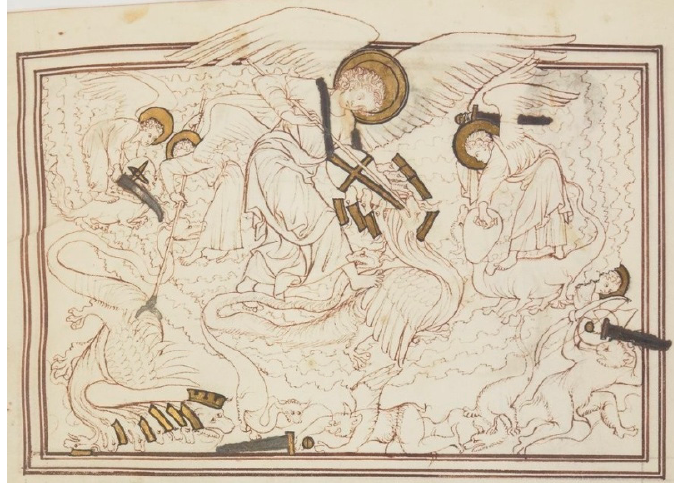
Figure 12. BNF 10474 (Paris Biblioth é que Nationale MS lat. 10474), Fol. 22 r , c. 1270–90, © Biblioth è que Nationale de